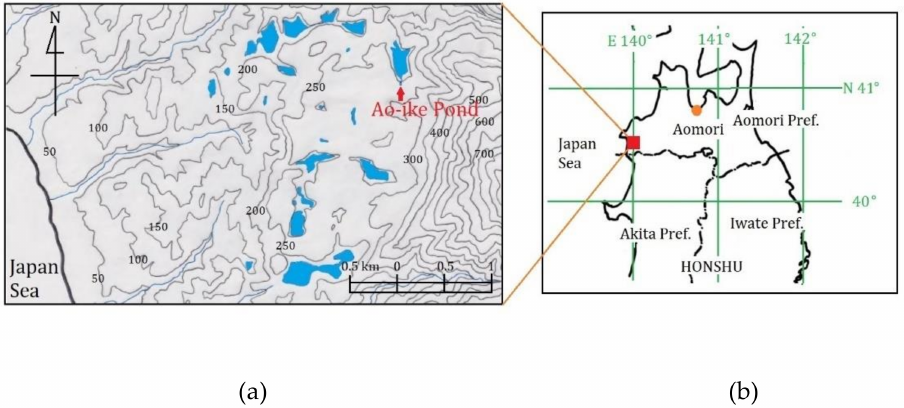
Figure 2. Location of Ao-ike Pond and the surrounding pond group of Juni-ko Lakes in the north- ern Honshu Island ( b ) and on the topographic map ( a ) of 50 or 100 m interval (elevation in m above sea